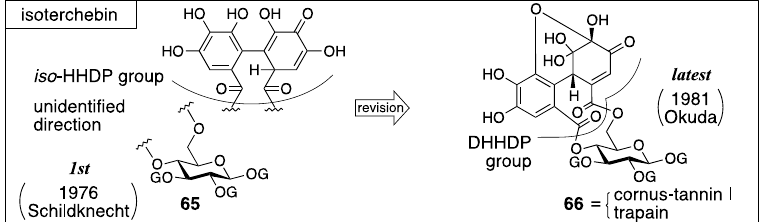
Figure 27. The transition of the structure of isoterchebin.